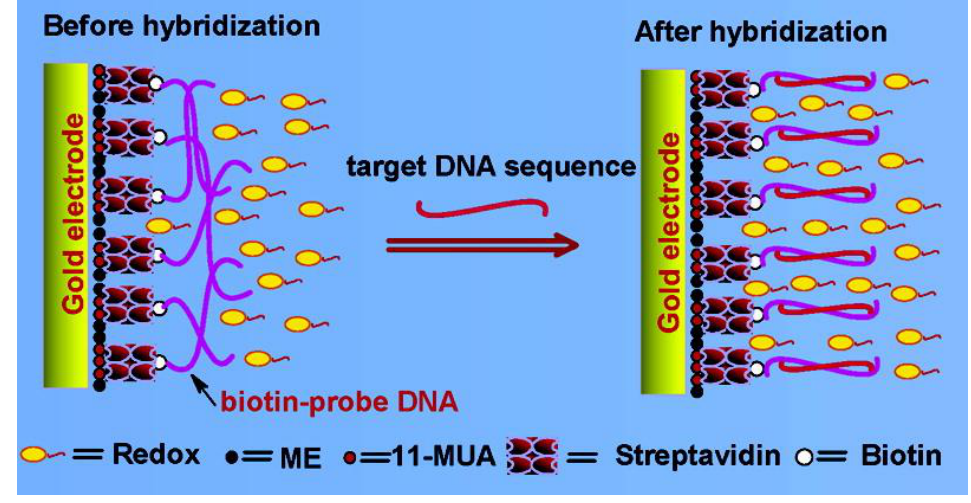
Figure 2. Schematic illustration of DNA probe immobilization through avidin-biotin chemistry and the hybridization of target DNA on a self-assembled monolayer (SAM)-modified Au electrode. (Reproduced with permission from [99]. Copyright 2014, American Chemical